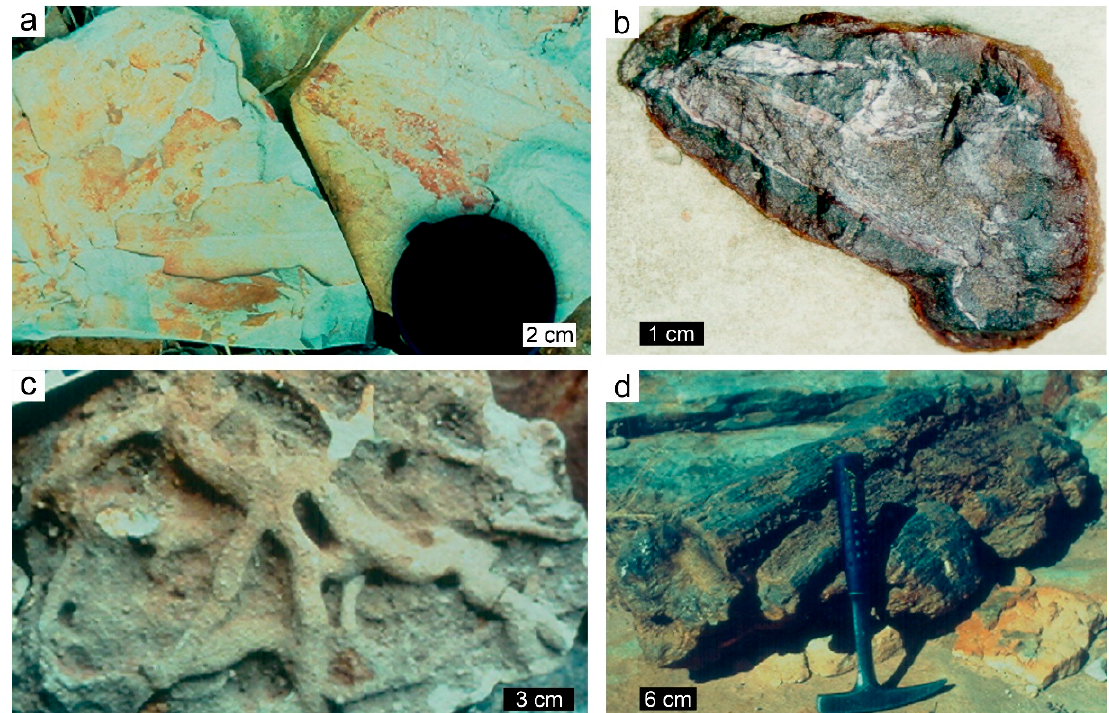
Figure 6. ( a ) vertical, cylindrical pipes with open apices, ( b ) simple, mostly vertical shaft ‐ like trace fossils, ( c ) close up of the wall of the digit ‐ like structure showing the extensively branching burrow system with random orientation( d ) Large ‐ scale trace fossils showing lateral bifurcations on a sub ‐ horizontal surface (modified from [37]).